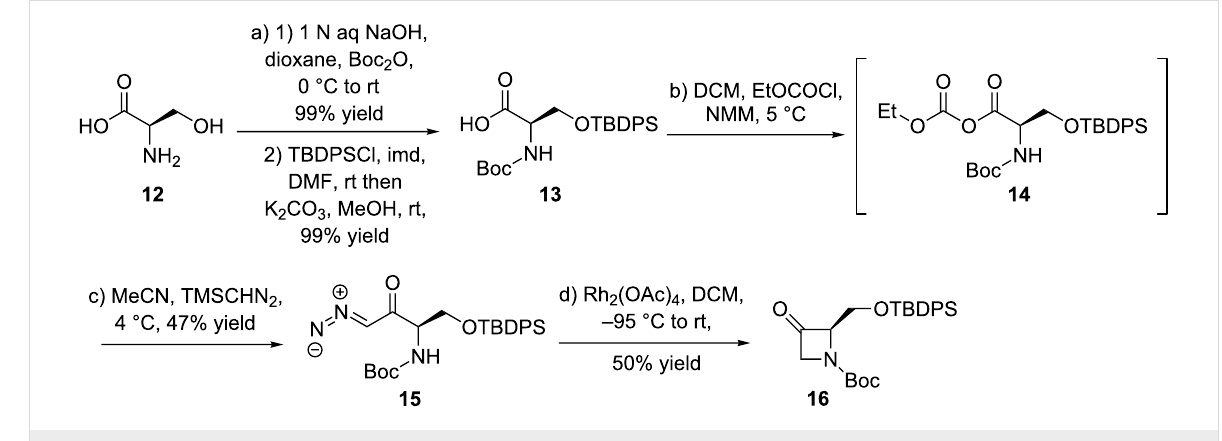
Scheme 2: Synthesis of 3-azetidinone derivative 16 .